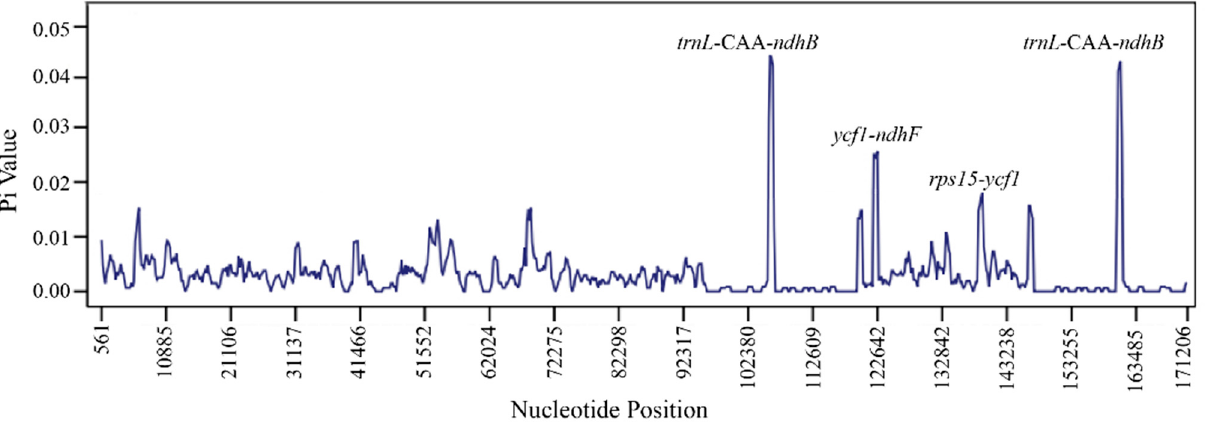
Figure 4. Nucleotide diversity and hotspot regions of four Anubias plastomes.